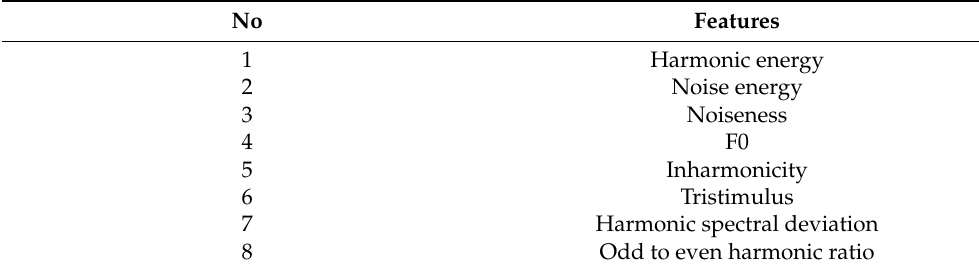
Table 1. Examples of sentences recorded for each emotion.